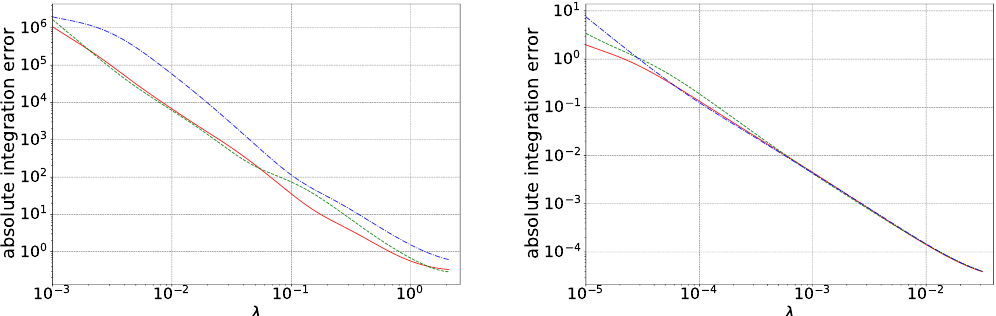
Figure 2: Absolute Monte Carlo integration errors for the first sector of the ladder2L (left) and the first sector of the elliptic2L (right) example as a function of a global λ = λ . For each case three different samples of 10 6 (cid:126) x ( j at the largest values of λ that still give valid